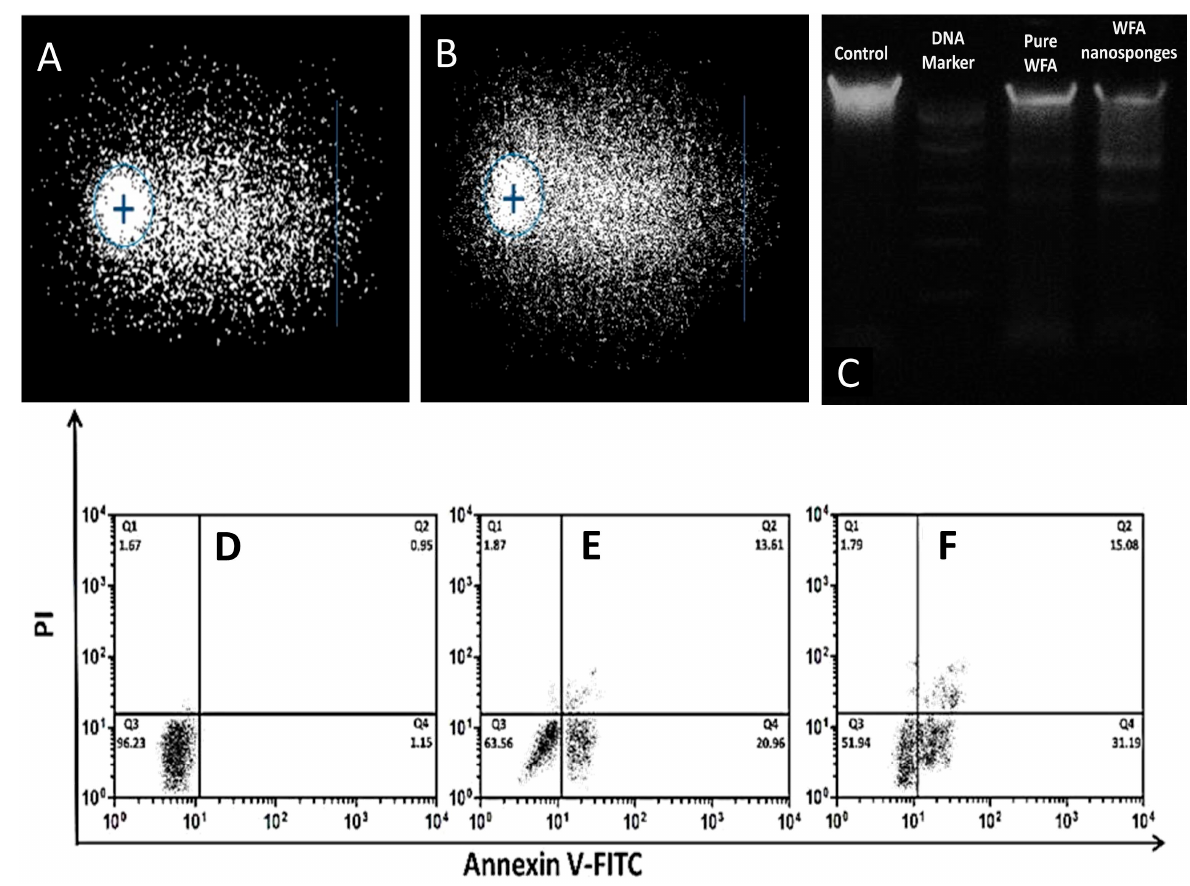
Figure 4. A representation of alkaline comet assay H 2 O 2 ( A ), WFA-NS ( B ). DNA fragmentation analysis utilizing 1 Kb DNA ladder, pure WFA and WFA-NS ( C ). The flow cytometry analysis of untreated ( D ) pure WFA ( E ) and WFA-NS ( F ) against MCF-7 cells.